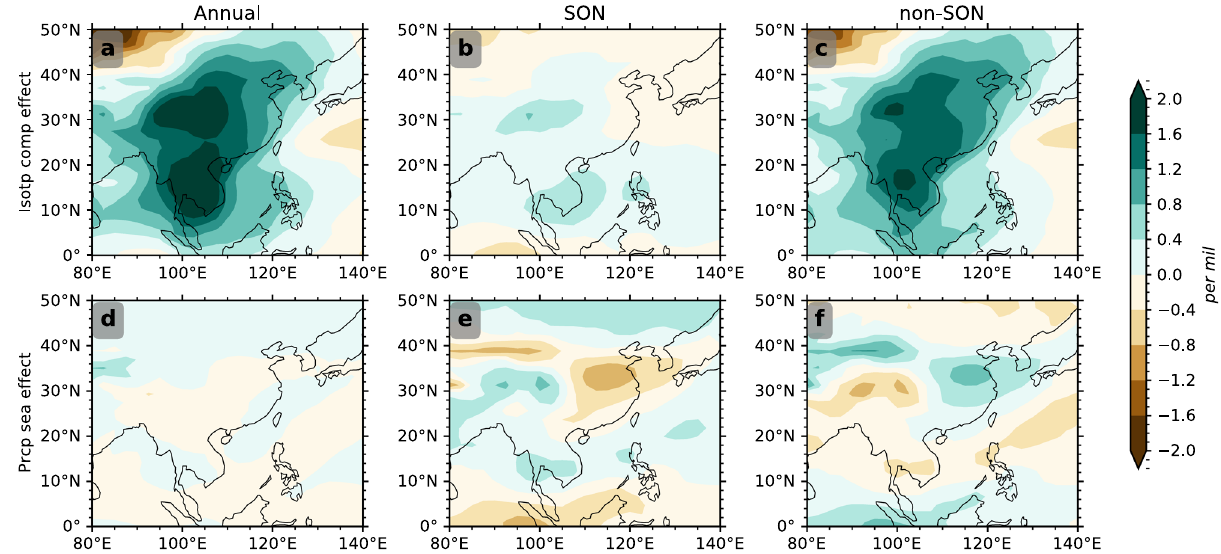
Fig. 5 δ 18 O p response between HS1 and LGM (HS1 – LGM). a Annual isotopic composition effect. b , c As in a but for portions of SON and